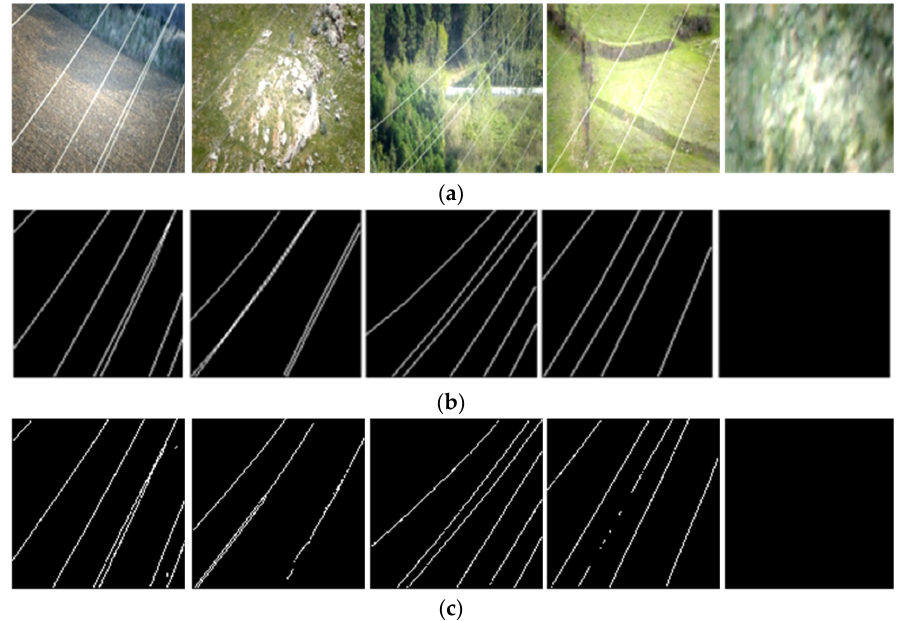
right). The snowfall environment brings certain difficulties to the PLE, so there are slight Figure 7. Test results in strong light environment. The first four show power line scene images, and the last one shows non-power line scene images (order from left to right). ( a ) Power line im- ages in a strong light environment. ( b ) Ground Truth. ( c ) The predicted results of the proposed method has a certain robustness in the snowfall environment as a whole. method.